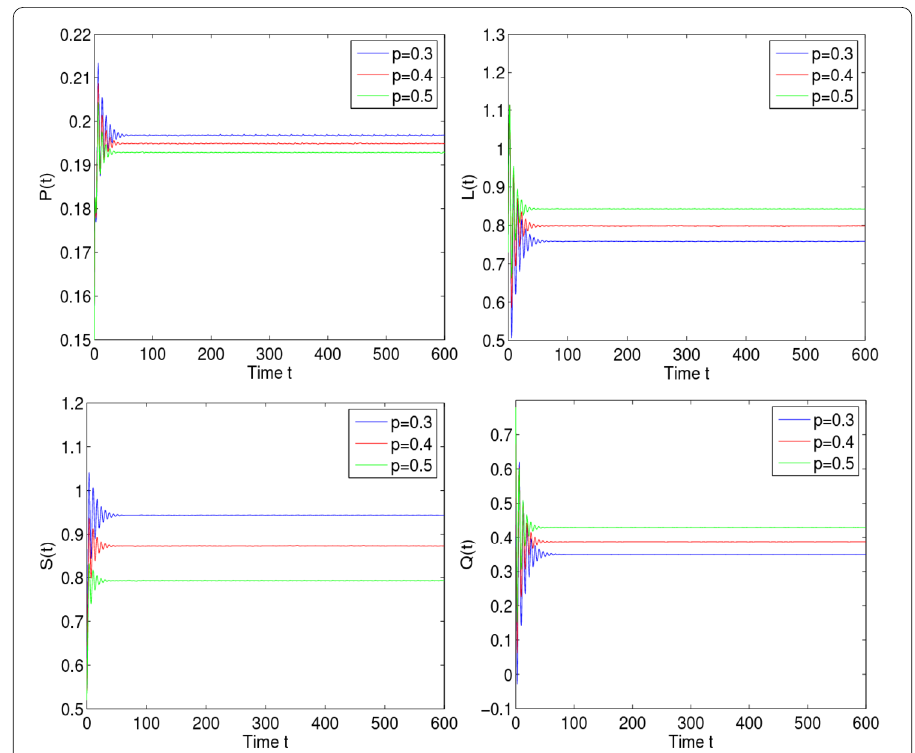
Figure 4 Time plots of P , L , S and Q for different p at τ = 2.0505. The rest of the parameters are taken as given in the